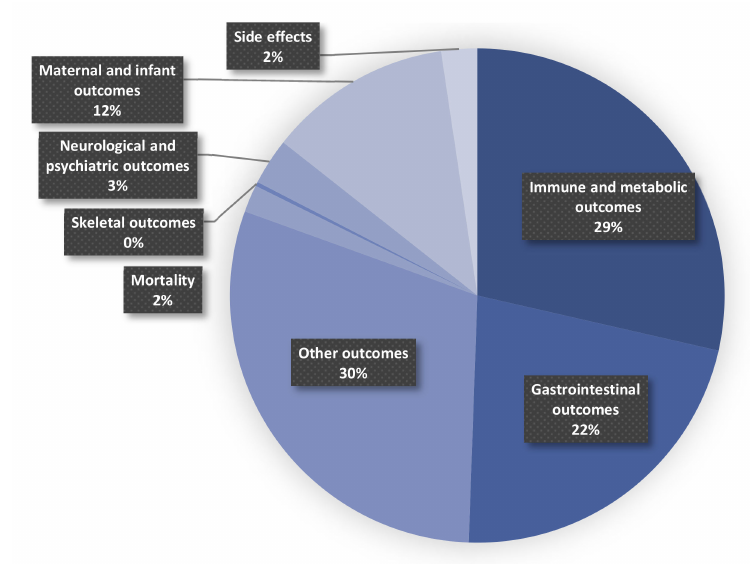
Figure 3. Map of outcomes related to